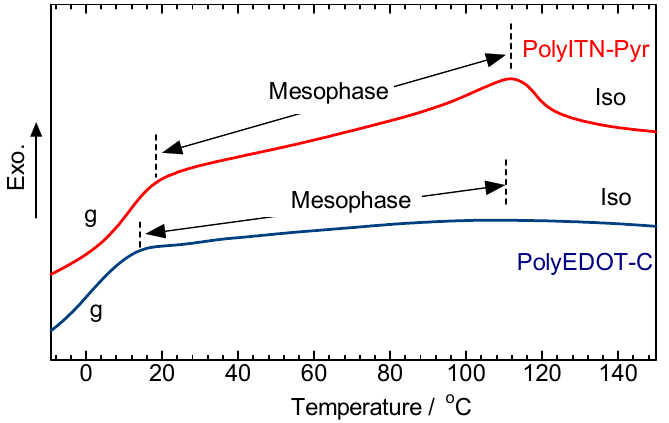
Figure 7. Differential scanning calorimetry (DSC) measurement results of polyITN-Pyr and polyEDOT-C in second cooling process at a scan rate of 10 °C/min. g = glassy state, mesophase = LC phase, Iso = isotropic.